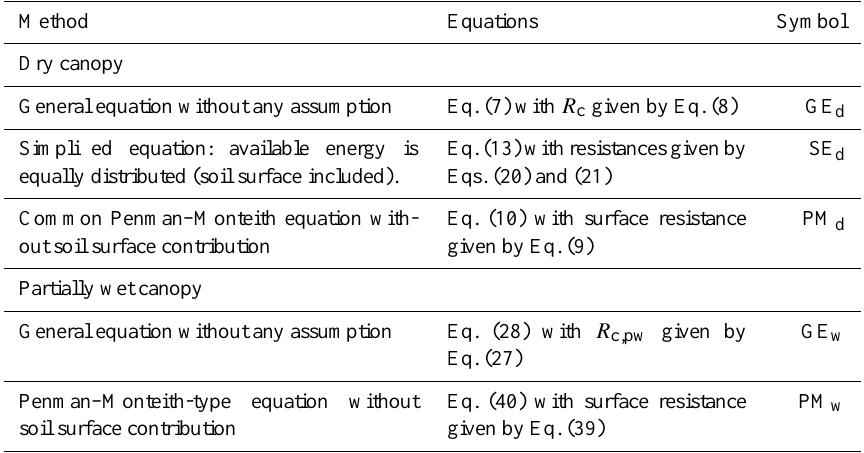
Table 1. Methods used in the numerical simulations to calculate canopy total evaporation with their corresponding equations and their symbol. Method Equations